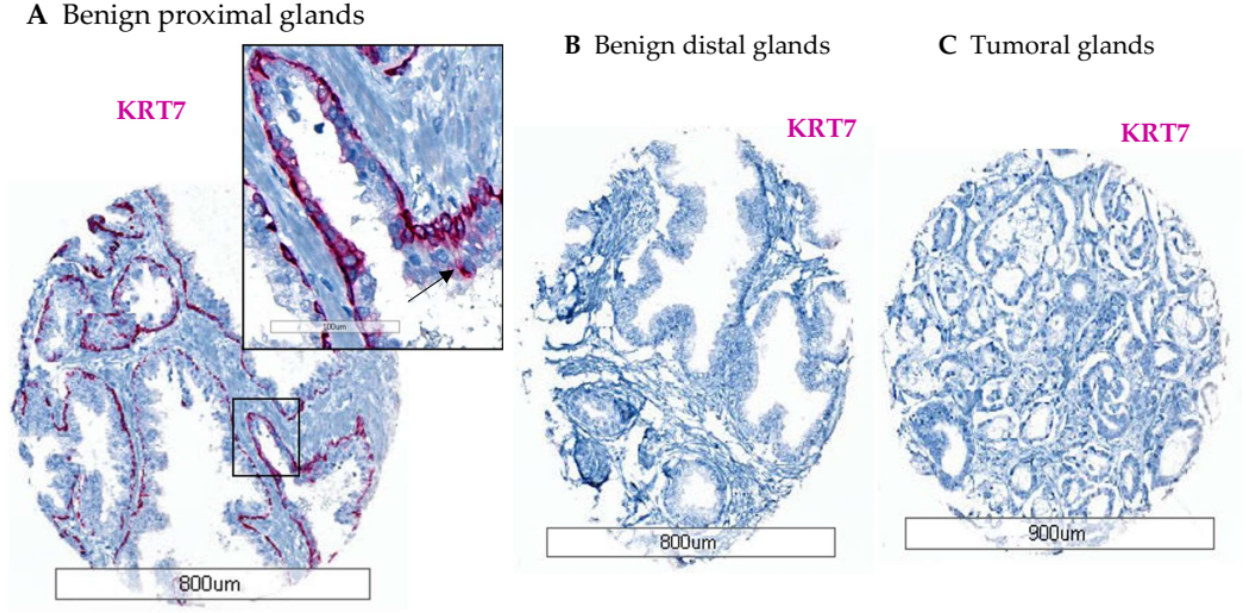
Figure 1. Examples of KRT7 staining by IHC using KRT7 rabbit SP52 clone on FFPE prostatic tissues from optimization-TMA. ( A ) Positive KRT7 staining was found in basal and supra-basal (arrow) cells from benign proximal peri-tumoral glands, ( B ) and negative staining in either benign distal glands, ( C ) or in a tumor core from acinar carcinoma. Alkaline phosphatase (AP) enzyme was used as a label for KRT7 detection in IHC.